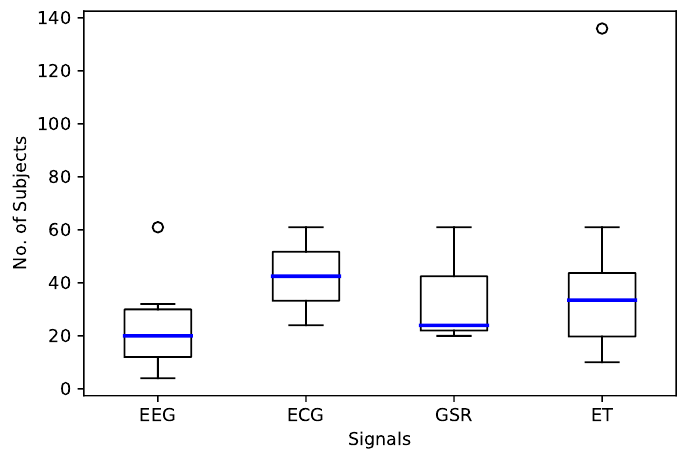
Figure 3. Number of subjects in experiments by